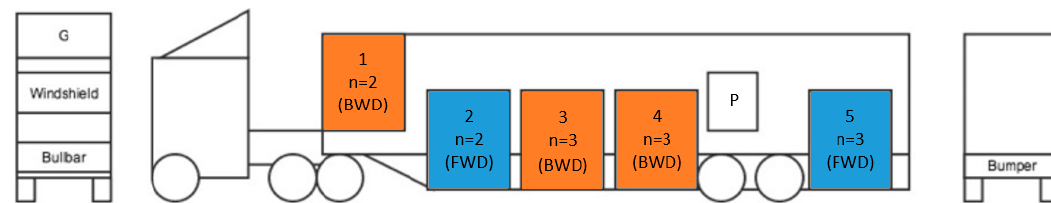
Figure 2. Truck configuration—the truck was sectioned into 5 compartments; blue bays are forward facing, orange bays are rear facing (BWD). Partitioning into single and wide bays is indicated as wide bays accommodated two horses (n = 2), and single bays accommodated three horses (n = 3) in each compartment. A personnel compartment ( p ) with seating for three people was located over the trailer’s rear wheels, with continuous access to the horses in compartments 4 and 5. Legend: FWD: forward facing direction; BWD: backward facing direction